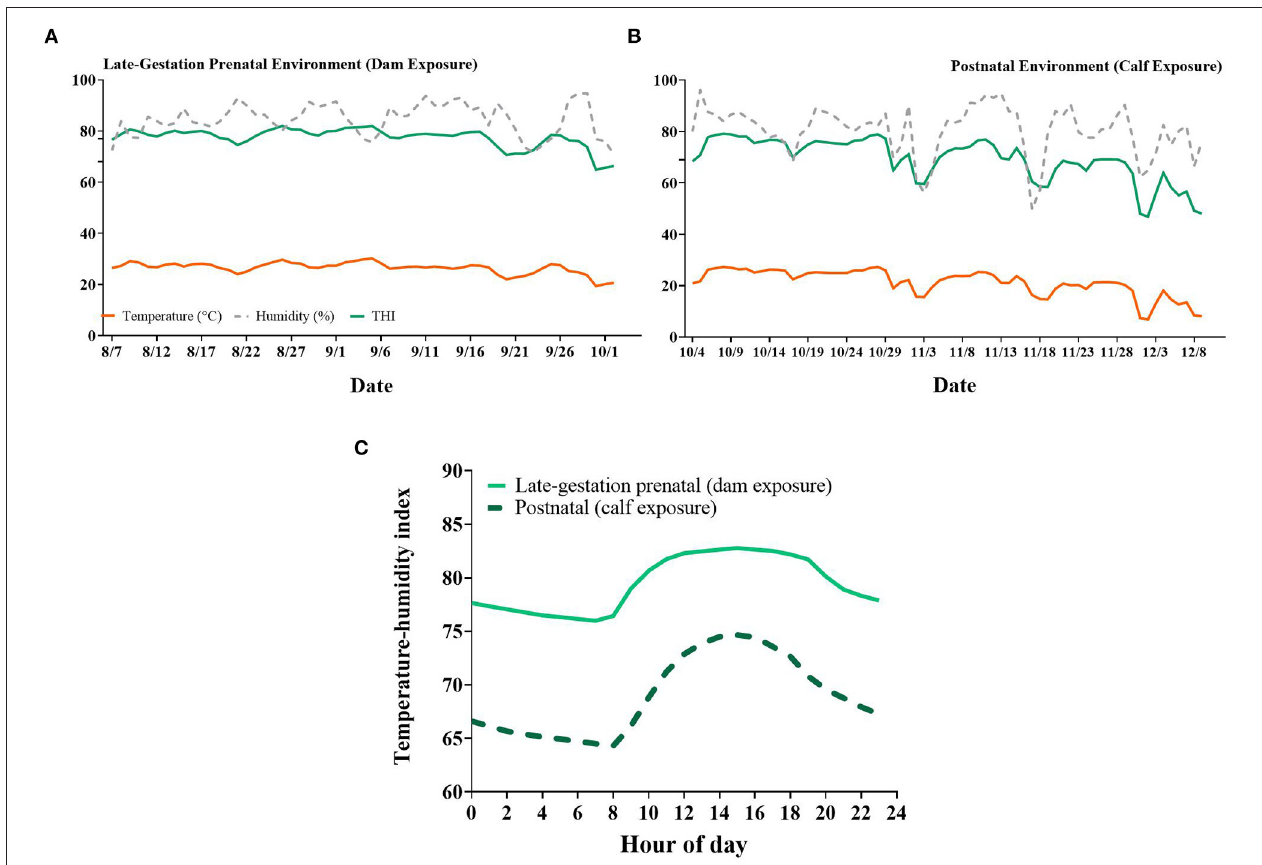
FIGURE 2 | Daily average ambient temperature, relative humidity, and temperature-humidity index (THI) of the surrounding environment during the (A) late-gestation prenatal (dam exposure) and (B) postnatal (calf exposure) periods of the present study. (C) Hourly average THI for prenatal and postnatal exposures. Data are presented as the average of all hours across one day (A,B) or the average of all days for each hour (C) . Additional ticks denote thresholds for cows set at 68 and 77 [ (A) ; Zimbelman et al., 2009; Ouellet et al., 2021] and for calves at 69 [ (B) ; Dado-Senn et al., 2020c].